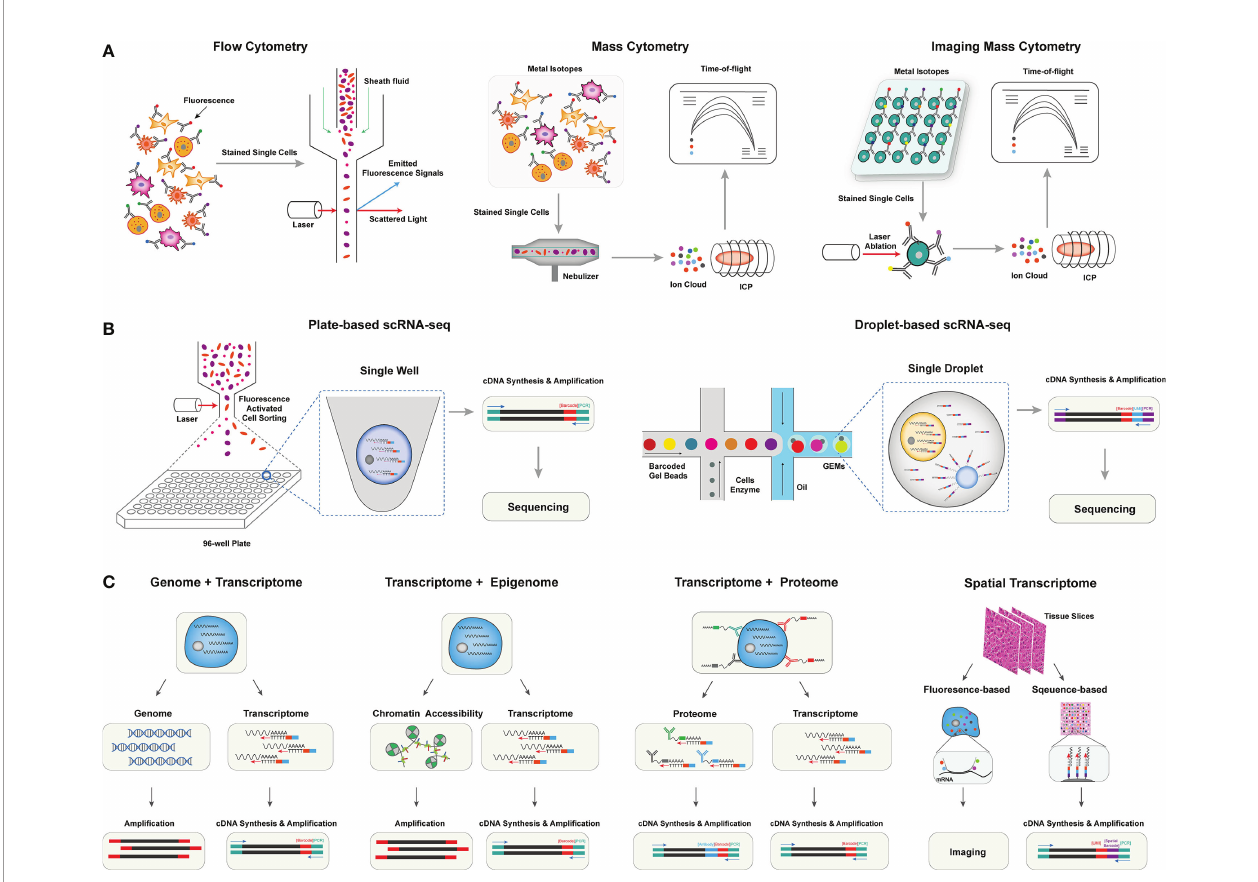
FIGURE 1 | The overview of single-cell omics techniques. (A) The overview of single-cell cytometry systems, including fl ow cytometry with fl uorescence-labeled antibodies for single isolated cells (left), mass cytometry with metal isotope-conjugated antibodies isolated single cells (middle), and imaging mass cytometry with metal isotope-conjugated antibodies labeled on tissues (right). (B) The overview of two canonical scRNA-seq platforms, including plate-based scRNA-seq methods with sorted cells barcoded within each well (left), and droplet-based scRNA-seq method, single cells were barcoded within individual droplets (right). (C) The overview of single-cell multi-omics techniques, including library preparing for genomic, epigenomic, proteomic, and spatial indexing with transcriptomic of single cells